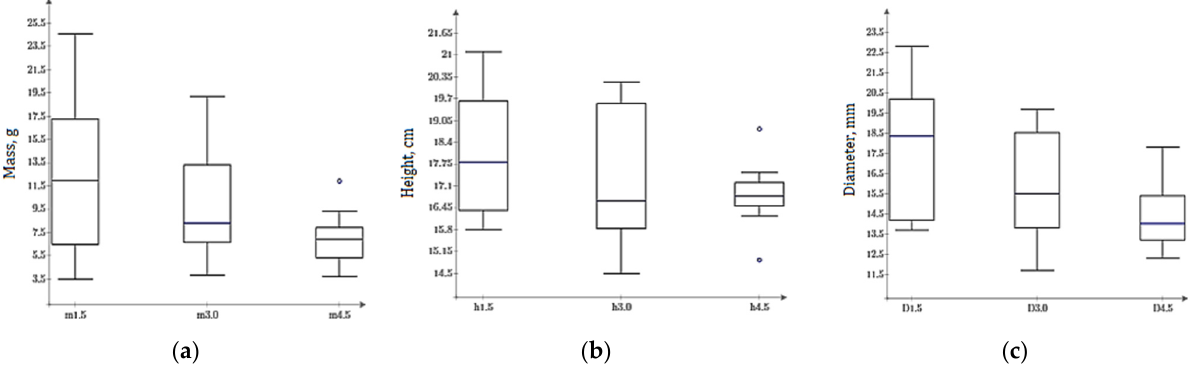
Figure 3. Box plot diagrams for mass ( a ), height ( b ), and diameter ( c ) distributions for the three cases of soil contamination with a solution of 1.5%, 3.0%, and 4.5% zinc concentration.